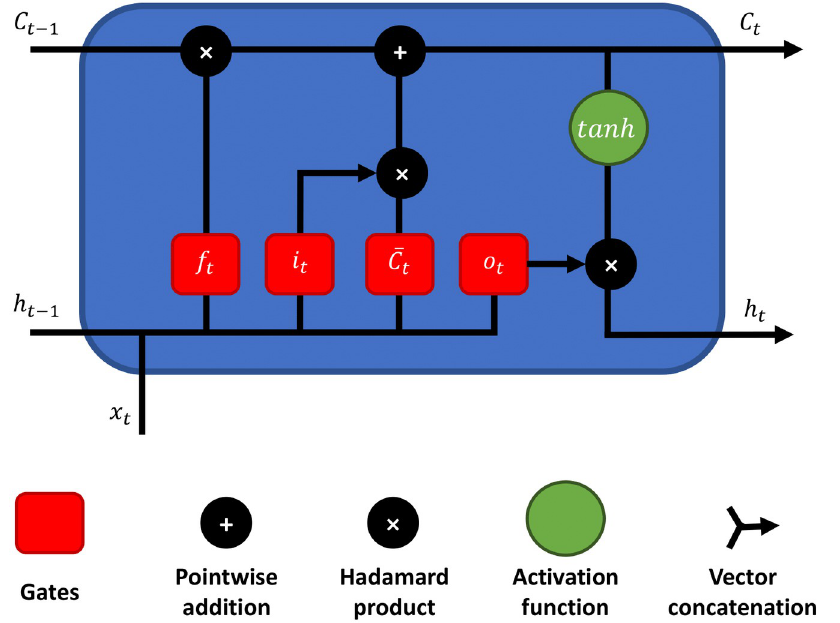
Fig 9. Diagram showing the structure of a LSTM